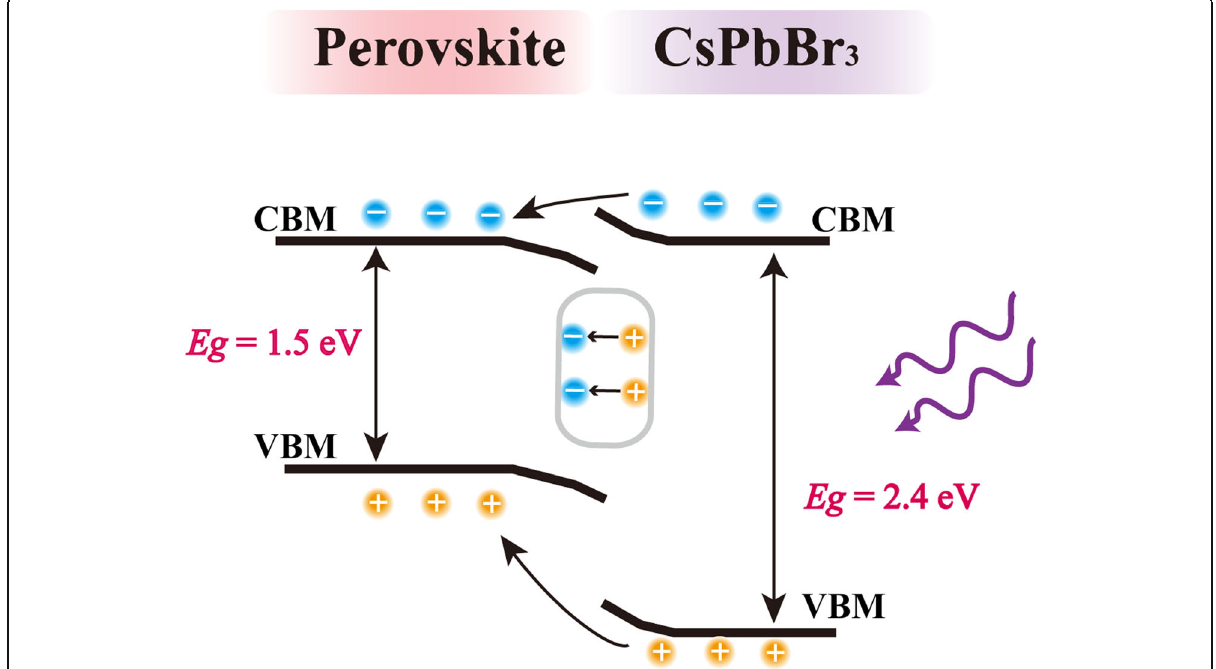
Fig. 5 Schematic of the band diagram of hybrid perovskite/CsPbBr 3